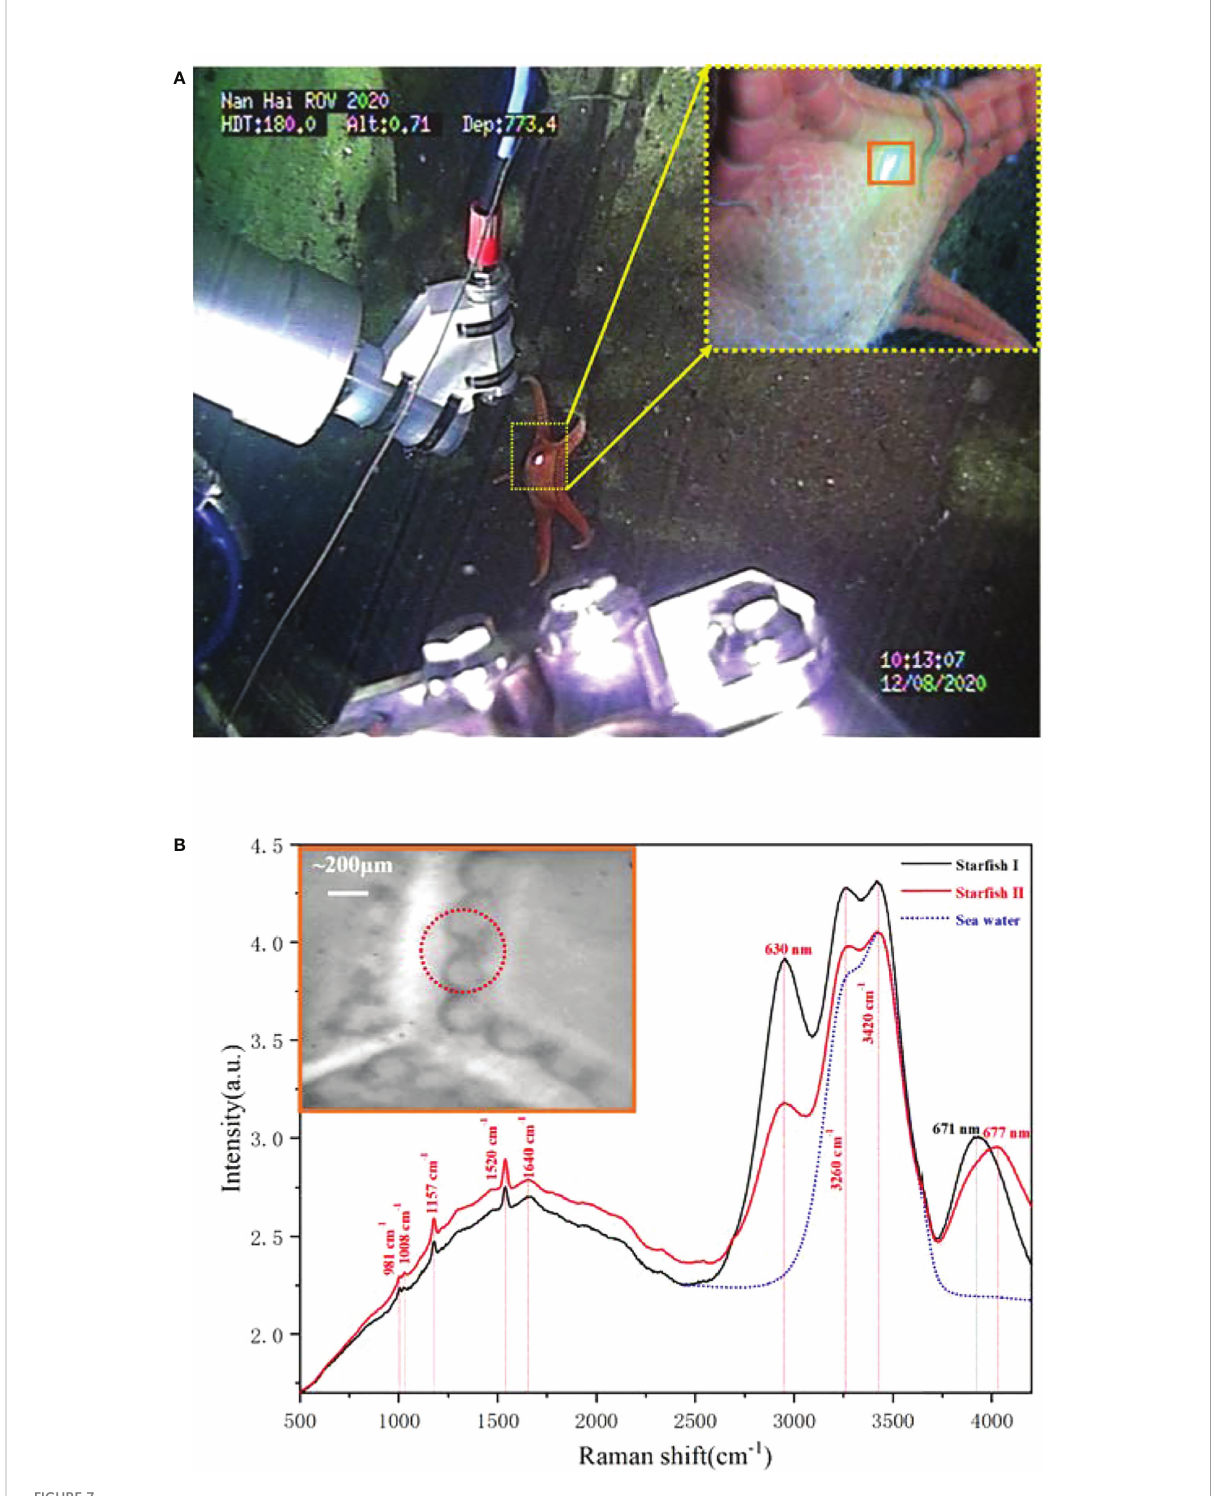
FIGURE 7 The in situ Raman detection of the star fi sh. (A) The scenes of in situ detection. (B) The Raman spectra of the star fi sh obtained at 773.4 m